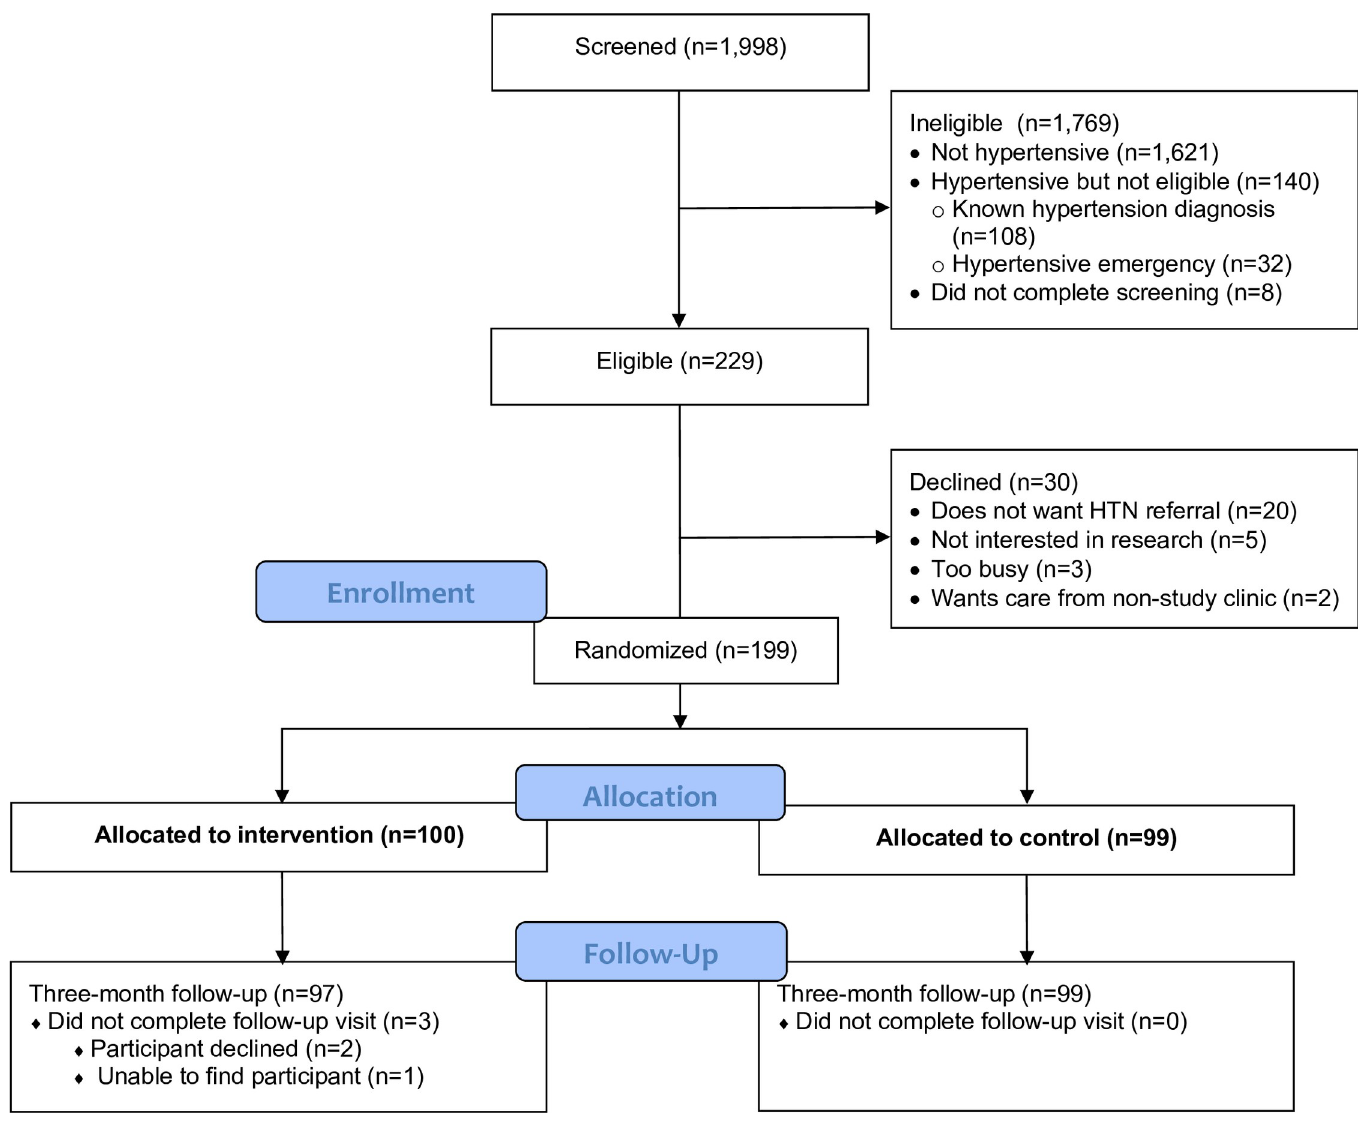
Fig 1. Consort diagram. baseline; 100 (50%) were tested, among whom one participant was newly diagnosed with HIV. Reasons for declining HIV testing included known HIV-positive status (n = 19), having a neg- ative test in the past 6 months and thus not meeting country guidelines for retesting (n = 41), declining testing (n = 14), and never linking to the clinic to offer HIV testing (n = 26). Primary and secondary outcomes Linkage to care within 30 days was 96/100 (96%) in intervention and 65/99 (66%) in control, a relative improvement of 45% (aRR 1.45, 95% CI 1.25–1.68; Table 2) and an absolute improve- ment of 30% (risk difference 0.30, 95% CI 0.20–0.40). The intervention improved linkage to care within 30 days across strata of age, gender, country, baseline hypertension severity, and HIV status (Table 3). The largest effect was seen among those with baseline blood pressure